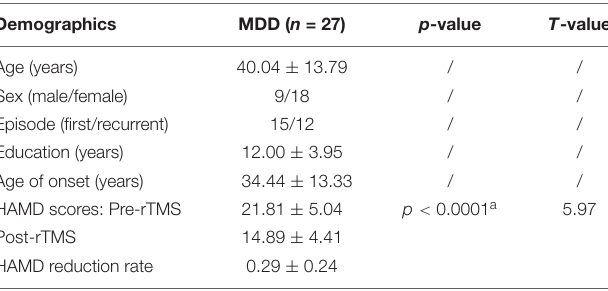
TABLE 1 | Demographics and clinical characters of MDD patients.